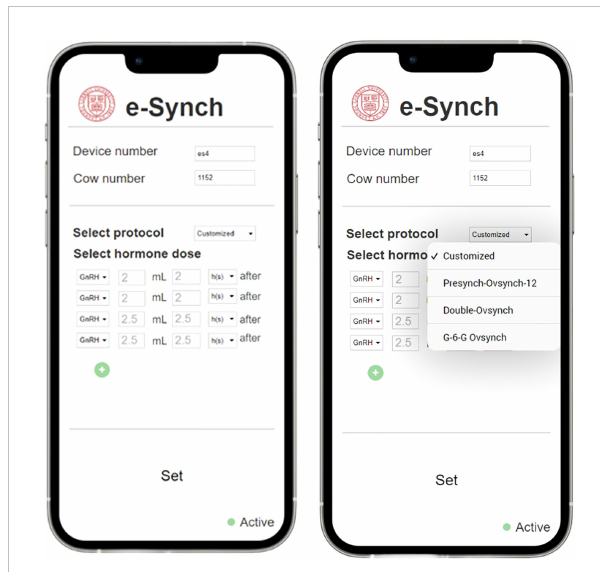
FIGURE 3 IOS app developed for remote control and monitoring of the e- Synch device. Pre-established and customizable drug delivery protocols can be selected. Users can use the control App to de fi ne a customized drug delivery protocol including the type, solution volume, and sequence of drug to release. The app send the protocol through Bluetooth Low Energy to the e-Synch